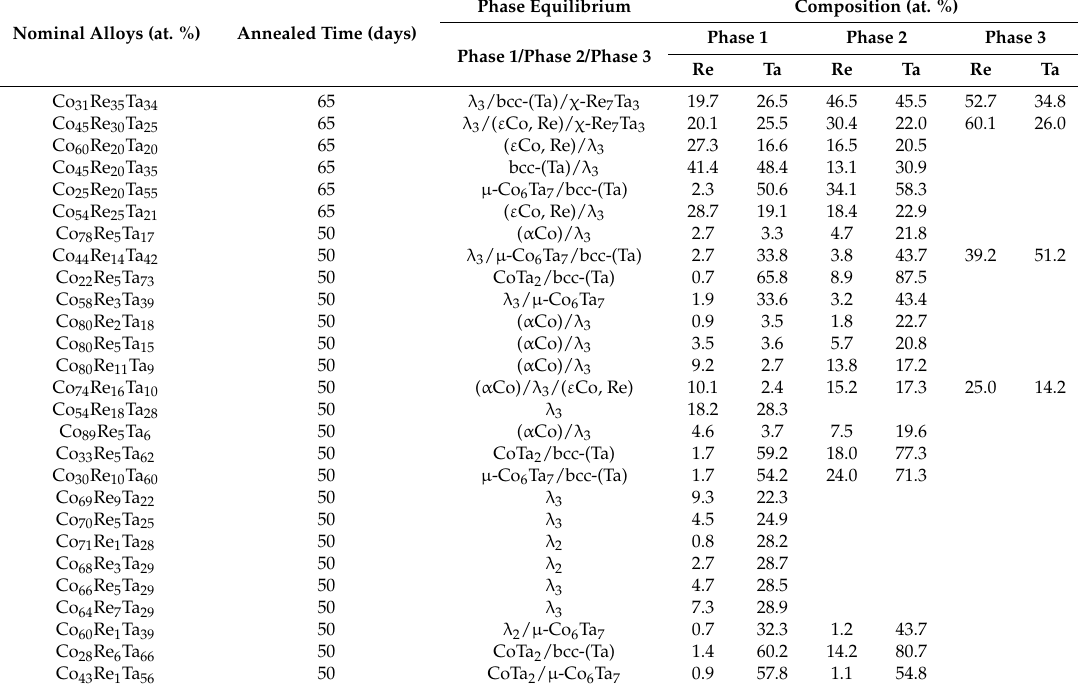
Table 2. Equilibrium compositions of the Co-Re-Ta ternary system at 1100 ◦ C as determined in the present work.